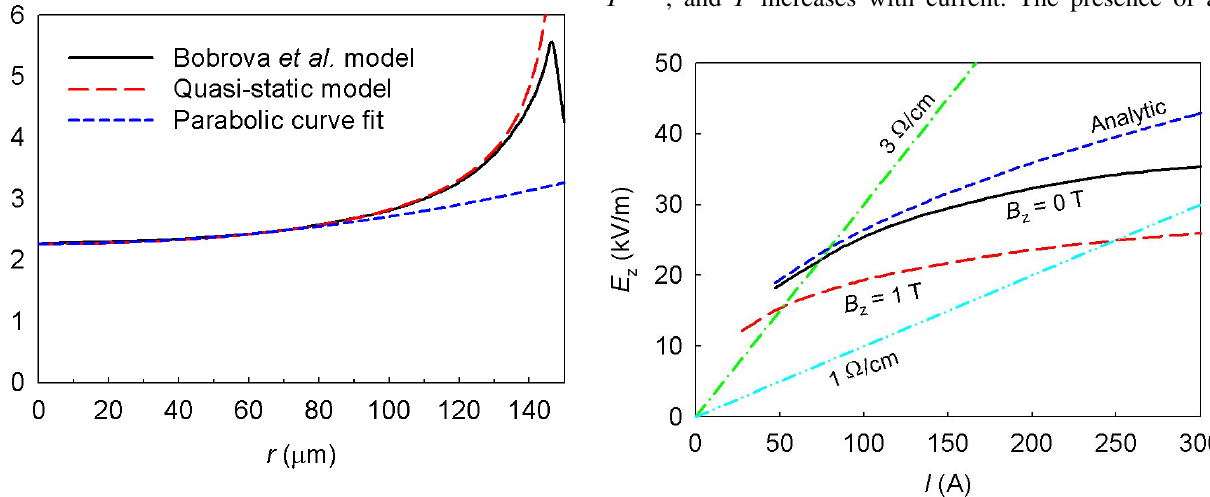
FIG. 2. (Color) Comparison of model predictions for plasma density versus radius. Plotted is the result given in Fig. 3 of Ref. [14] at 80 ns (solid curve) and the quasistatic model prediction (red long-dashed curve). A parabolic fit to the inner portion ( r < 75 (cid:2) m ) is also shown (blue short-dashed curve).